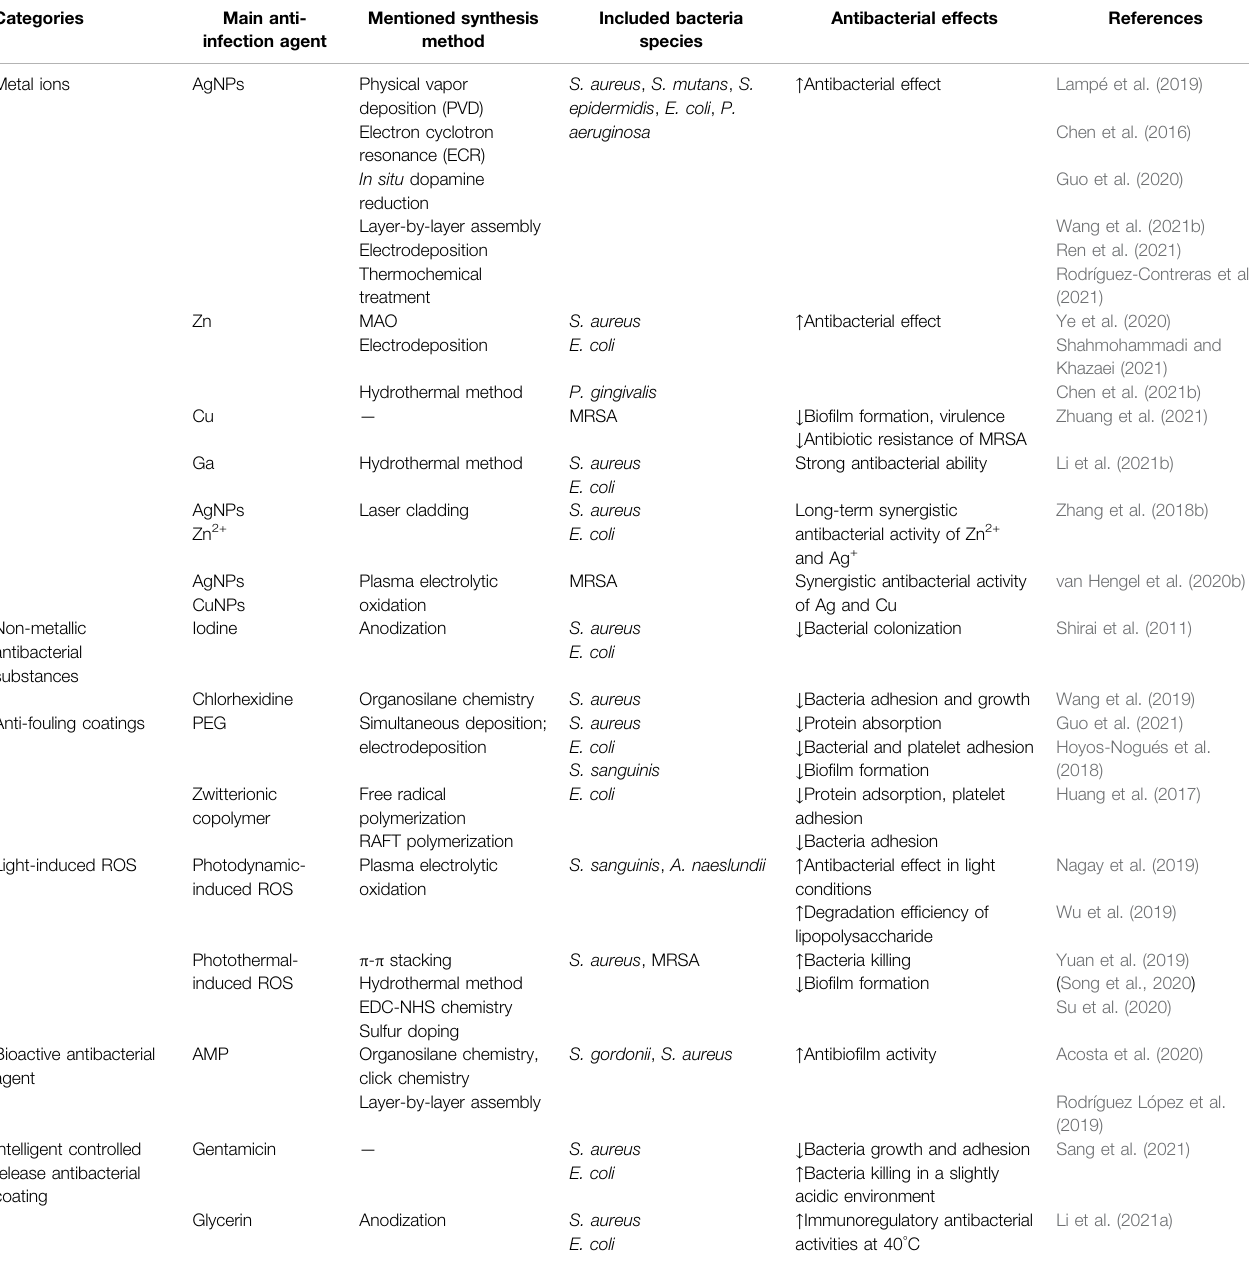
TABLE 2 | Recent development of antibacterial coatings on titanium